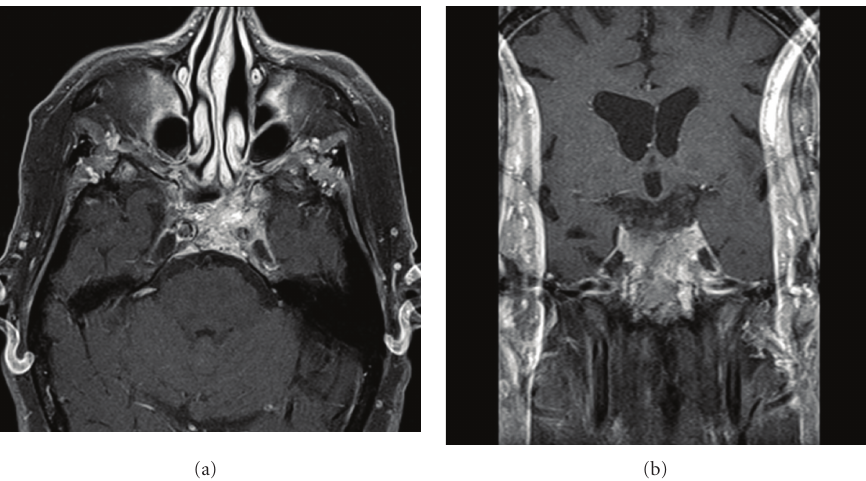
Figure 3: Axial and coronal T1-weighted MR imaging with gadolinium enhancement showing a homogenously enhancing soft tissue mass involving the clivus, pituitary fossa, cavernous sinus, and posterior nasal cavity.